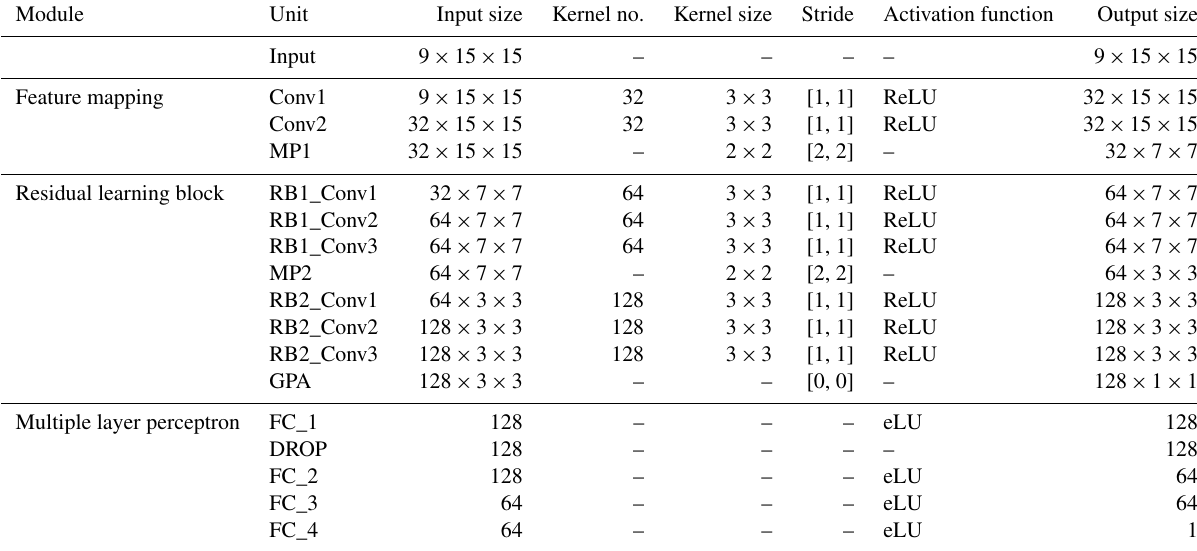
FC_3 64 eLU FC_4